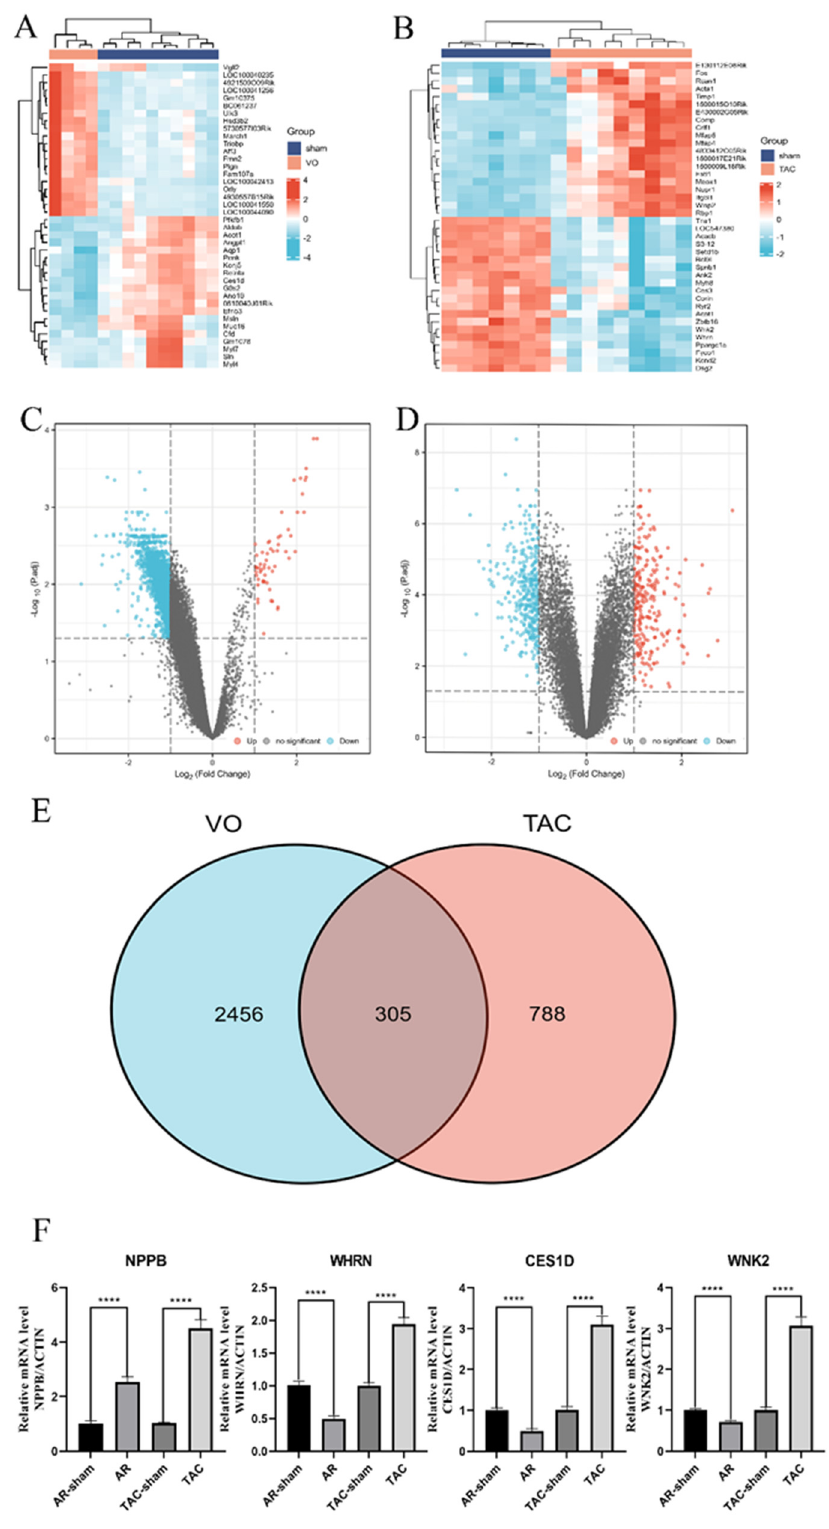
Figure 2. The volcano plot, heatmap, and qPCR of DEGs. The gradient color from blue to red represents the gene expression value (( A ): VO group/sham group; ( B ): TAC group/sham group) from down-regulation to up-regulation, respectively. DEGs: differentially expressed genes. The volcano plot of DEGs: red and blue dots represent up-regulated and down-regulated genes, respectively. ( C ) is VO group vs. sham group; ( D ) is TAC group vs. sham group. ( E ) is the Venn analysis of VO and TAC. ( F ) is qPCR results of RNA from mice that received AR or TAC. ****: p -value <